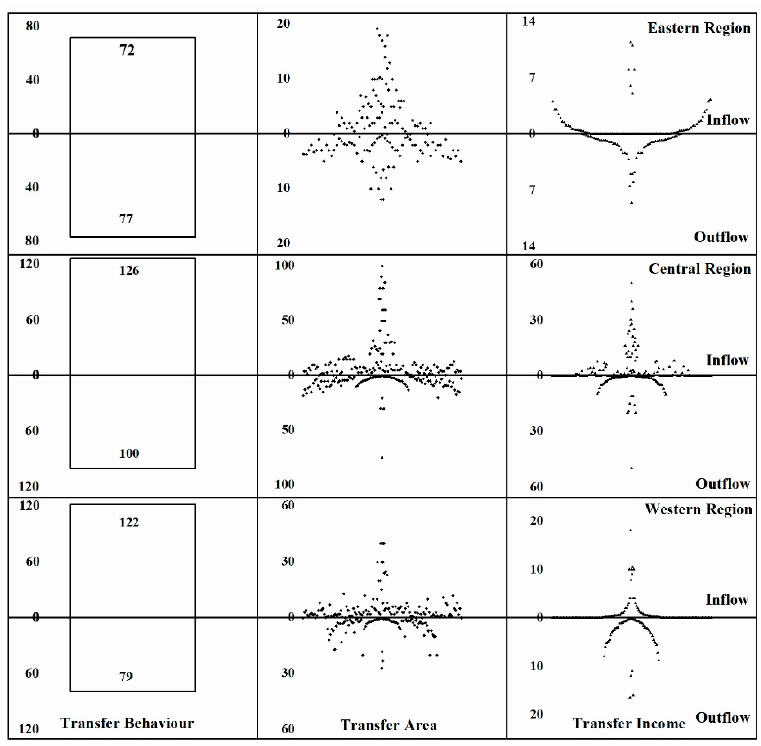
Figure 3. Descriptive statistics of dependent variables.